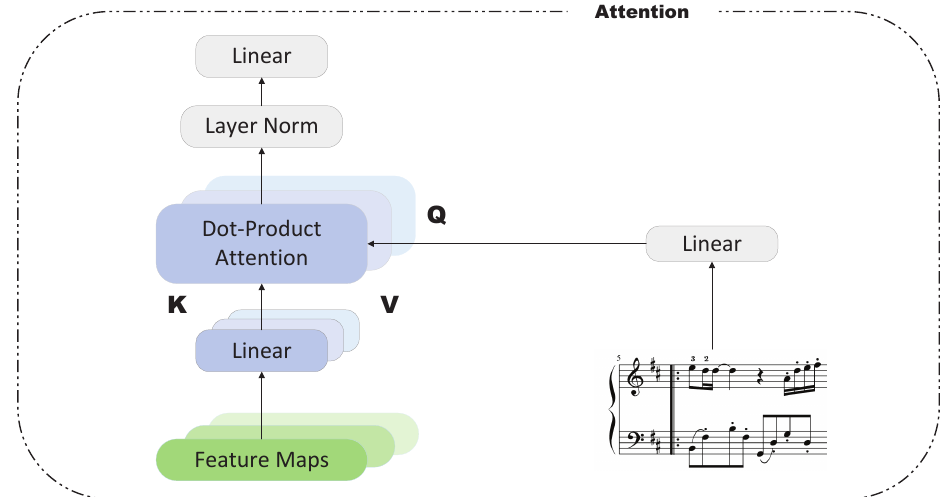
Figure 7. Schematic diagram of the musical attention